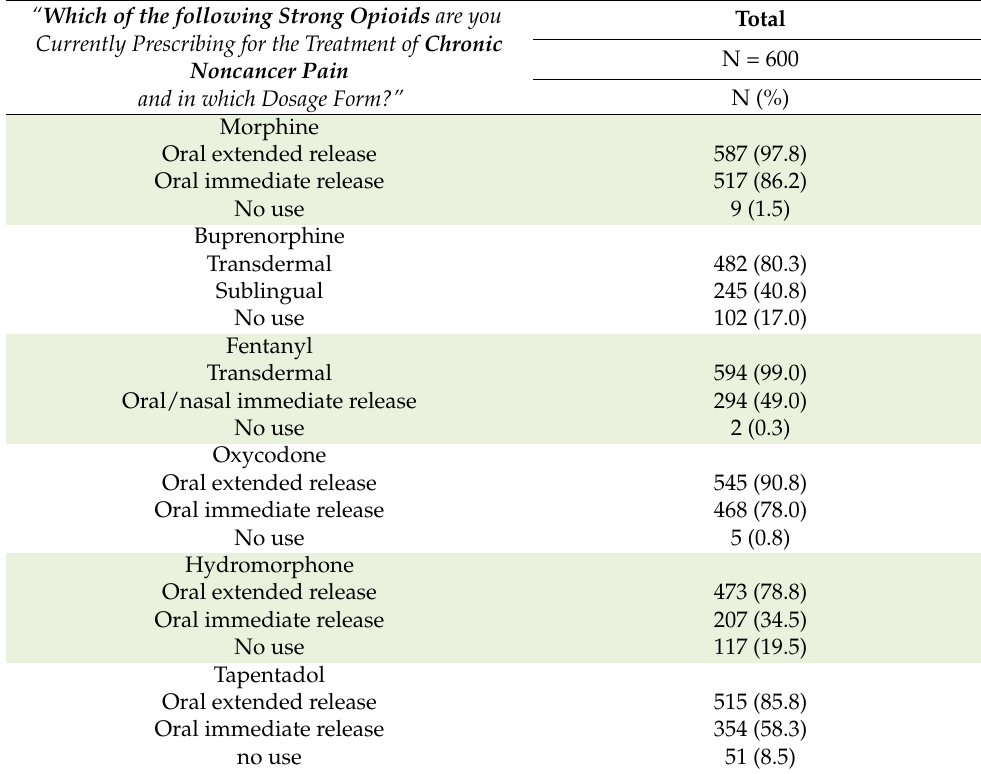
Table 2. Self-reported opioid prescribing behavior: opioid variant and formulations. “ Which of the following Strong Opioids are